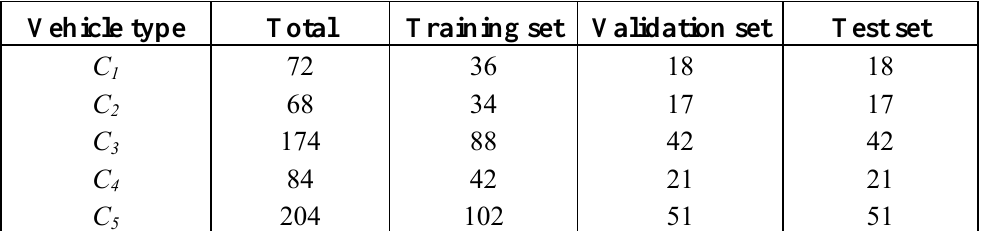
Table 3. Numbers of Labeled Records.